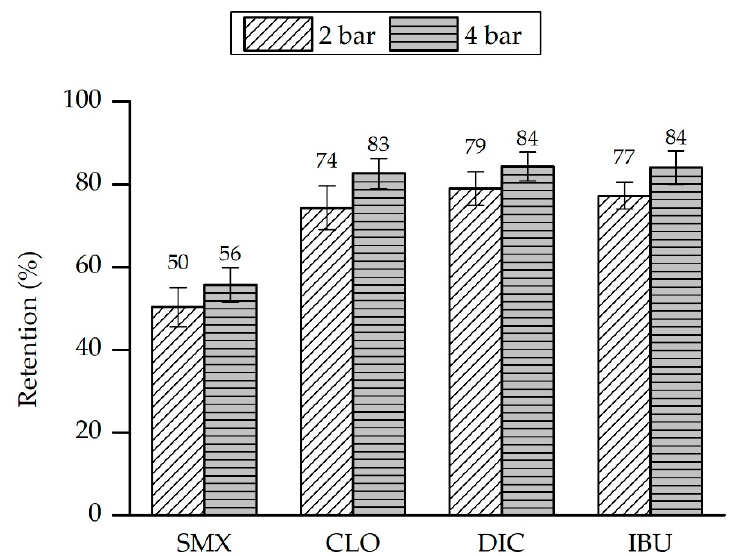
Figure 13. Rejection of pharmaceuticals by a hybrid membrane in feed water with 0.1 mg/L of each micropollutant.